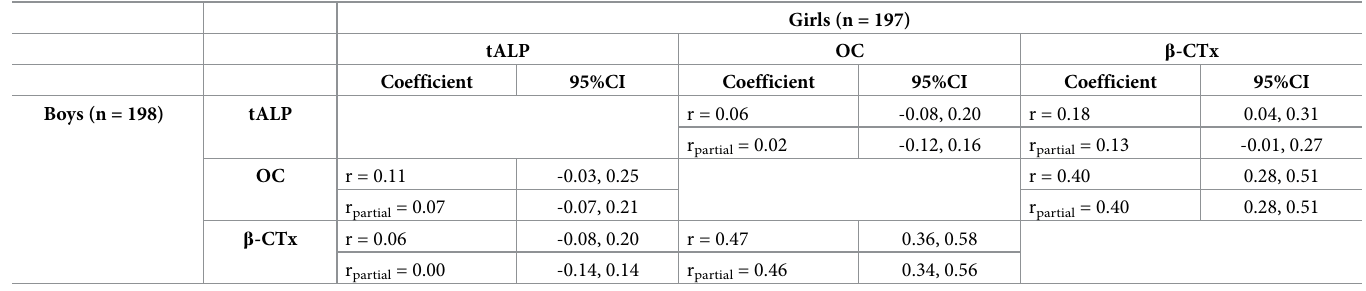
Table 2. Pearson correlation and partial correlation coefficients among bone metabolism markers, in girls and boys (n =